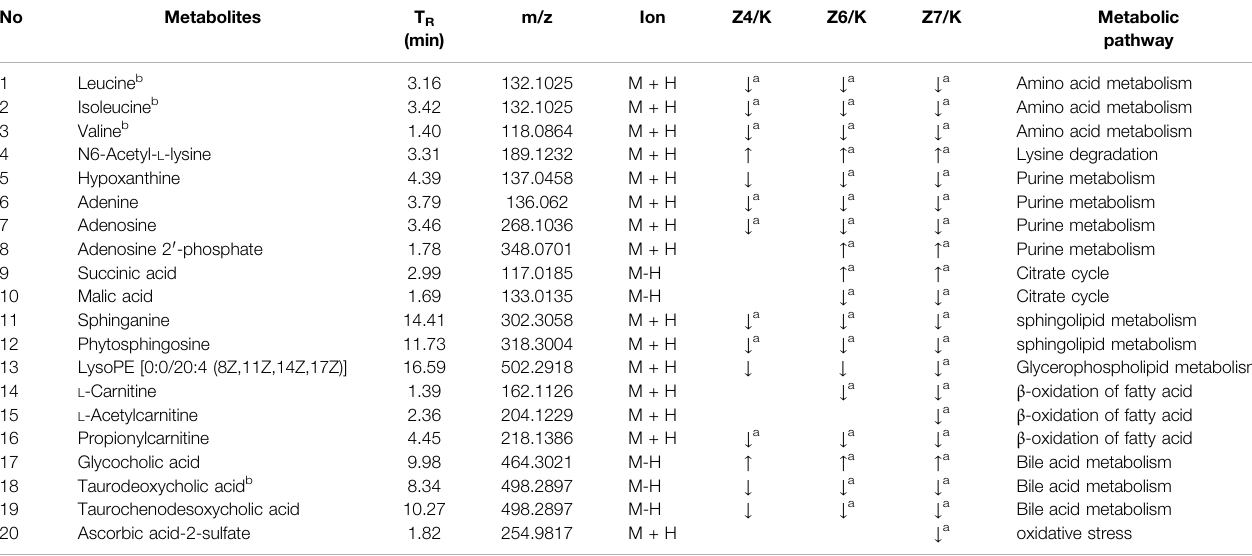
TABLE 6 | Identi fi ed differential metabolites in the liver of healthy